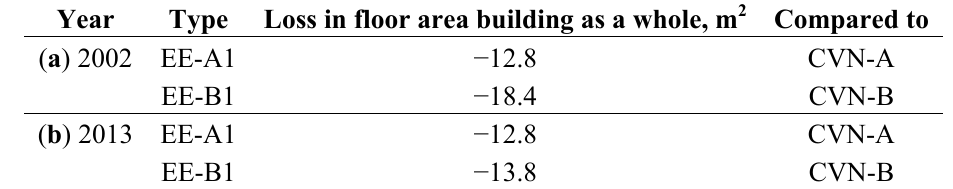
Table 3. ( a ) Loss in floor area between conventional and energy-efficient building, year 2002. ( b ) Loss in floor area between conventional and energy-efficient building, year 2013.